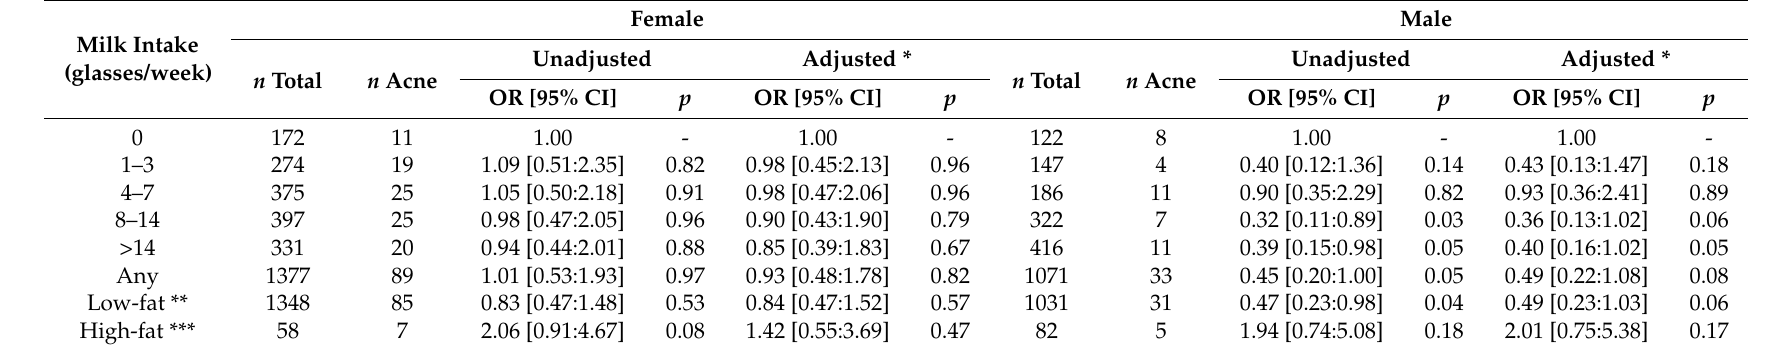
Table 2. Odds ratio for acne by milk intake in the age group 20–39 years.